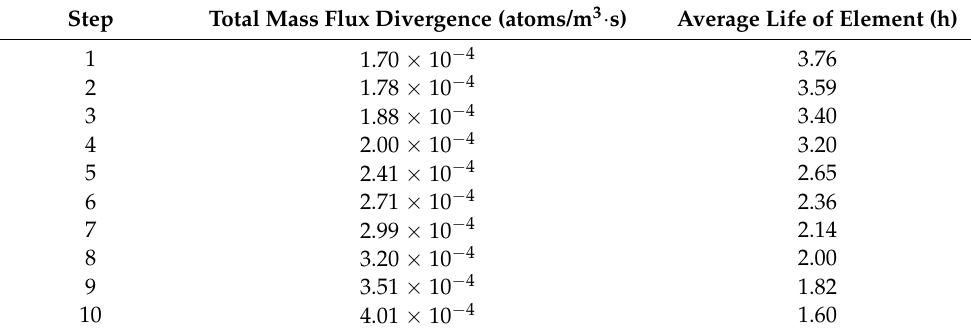
Table 3. Parameters of solder joints in each step.